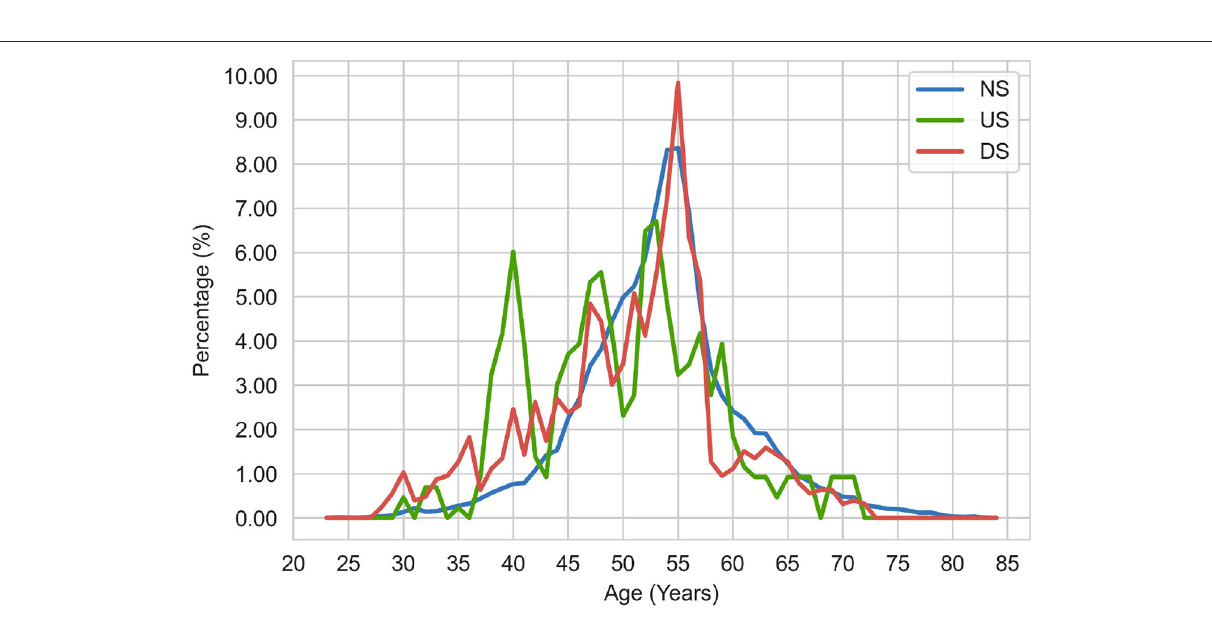
FIGURE 4 | Distribution of chairperson age across different company performance